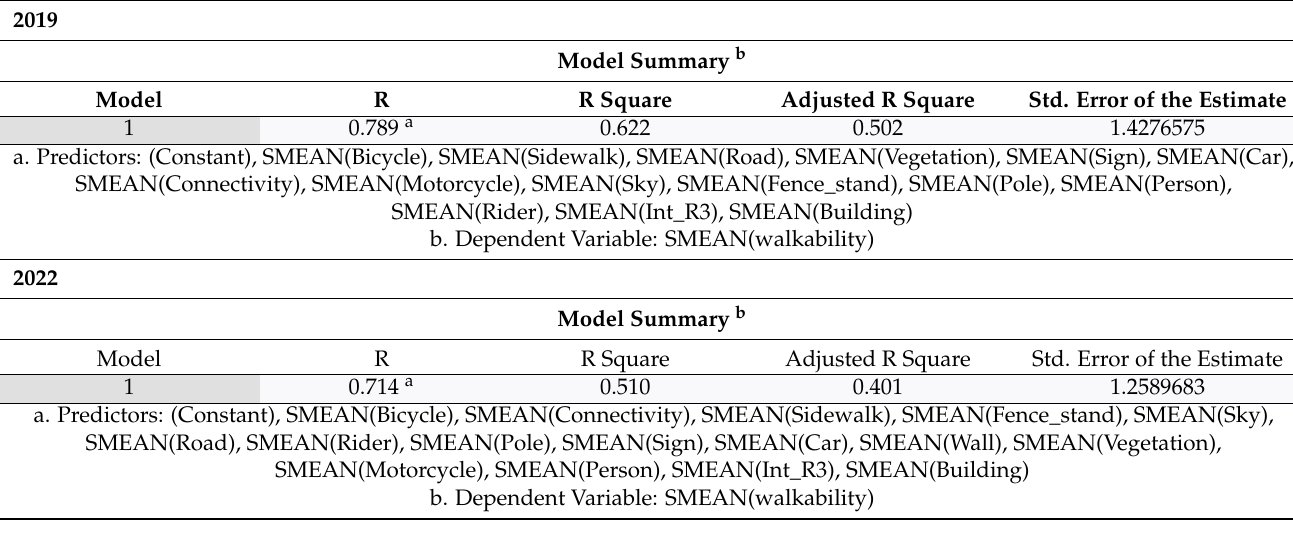
Table 4. Coefficients of Determination.